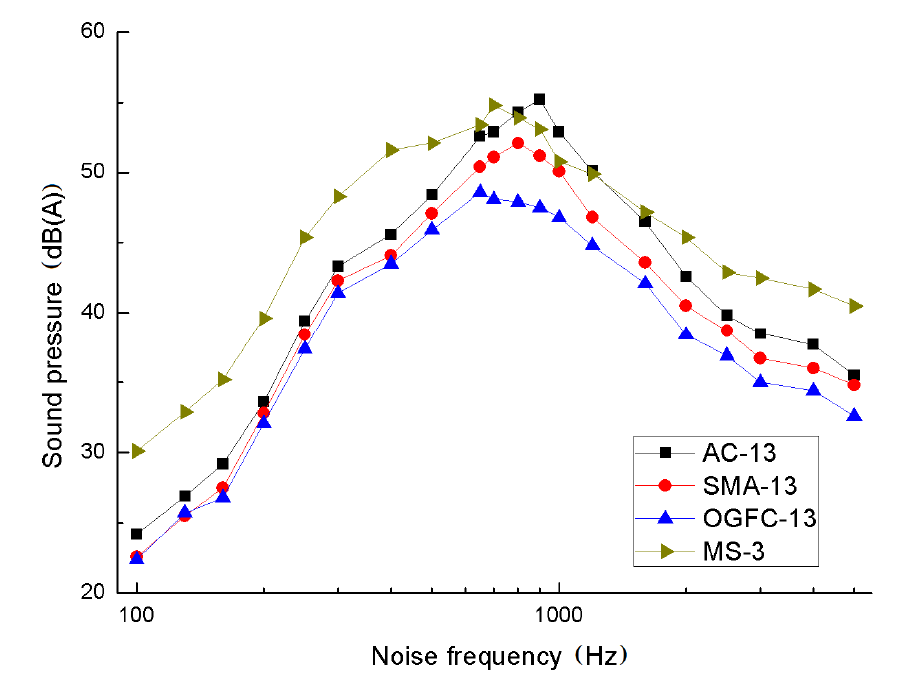
Figure 14. Tire–pavement noise frequency curves of different materials.